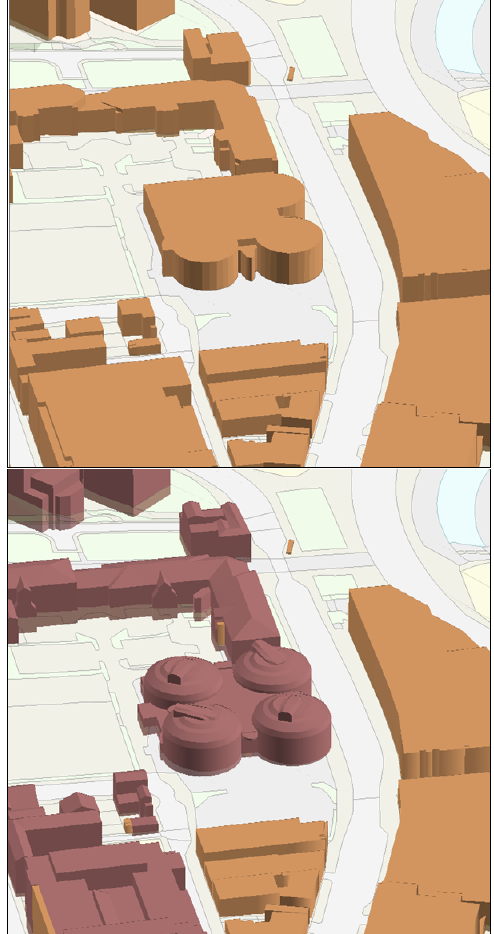
Figure 4: Comparing LoD 1 (top) and LoD 2 data (bottom) for the same